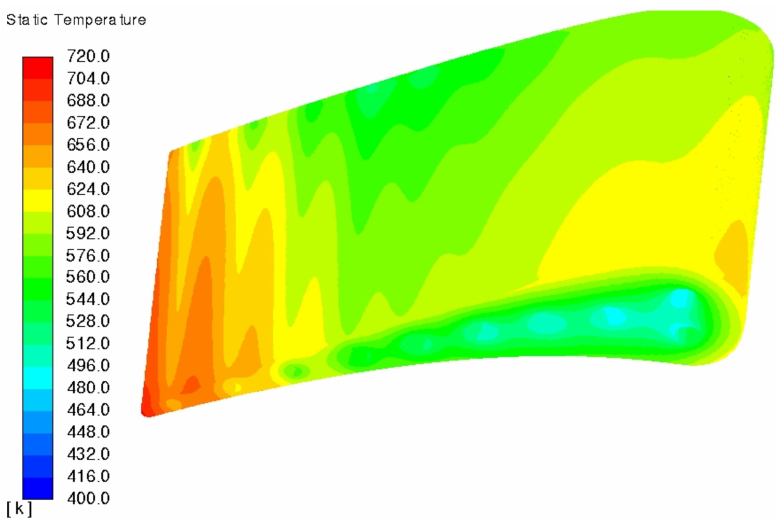
Figure 10. Suction side temperature plot of model 1, run 158 ( k − ω